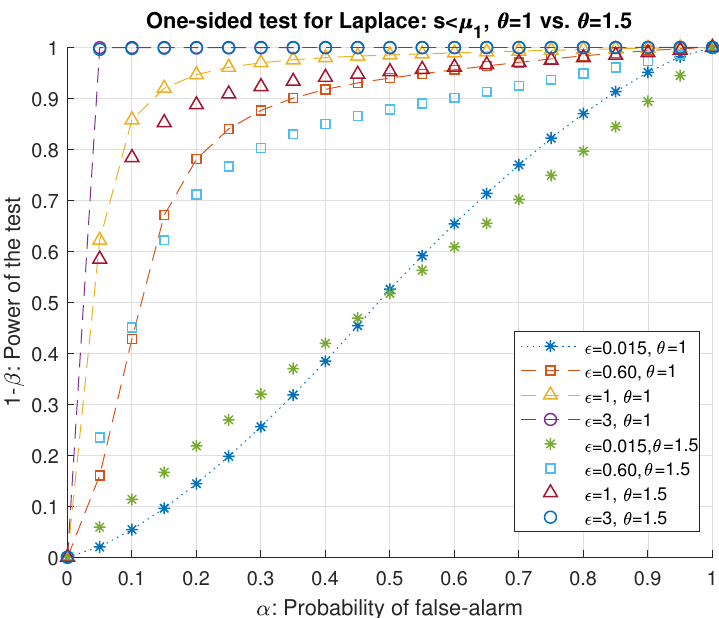
Figure 1. ROC curves for the one-sided hypothesis test ( ∆ µ = µ 1 > 0): (20) vs. (29) and (22) vs. (32) for different values of privacy parameter and s < ∆ µ where µ 0 = 0.